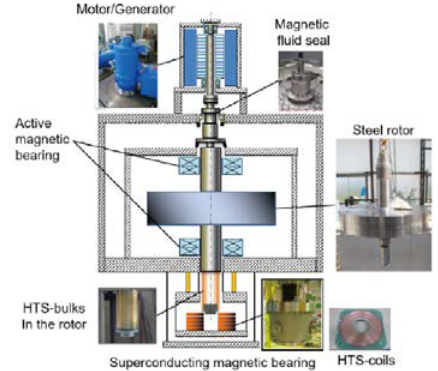
Fig. 7. ConFigureuration of FESS demonstration machine of